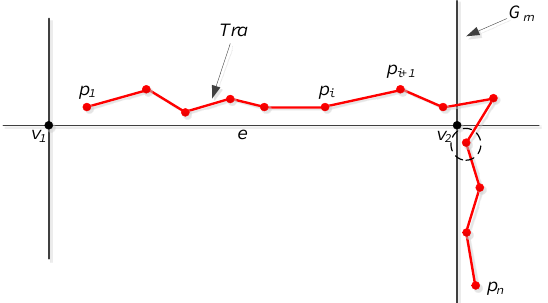
Figure 2. An example of feature points in a trajectory In Figure 2, Tra in red colour is a trajectory, p 1 and p n are the endpoints. v 1 and v 2 are junctions. The point in dashed circle is the closest to v 2 , and it is a feature point of Tra